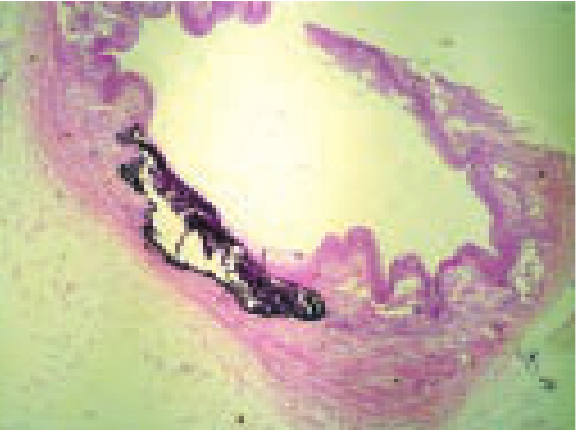
Fig. 5 - Microscopia das artérias. Placa de ateroma calcificada, com invasão até camada muscular, sem causar obstrução na luz do vaso - Coloração hematoxilina-eosina.